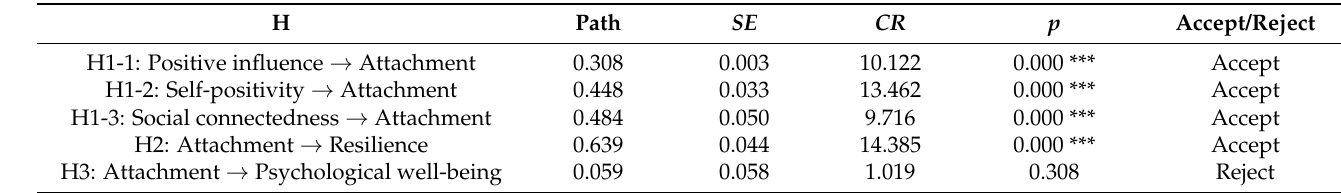
Table 5. Hypothesis testing